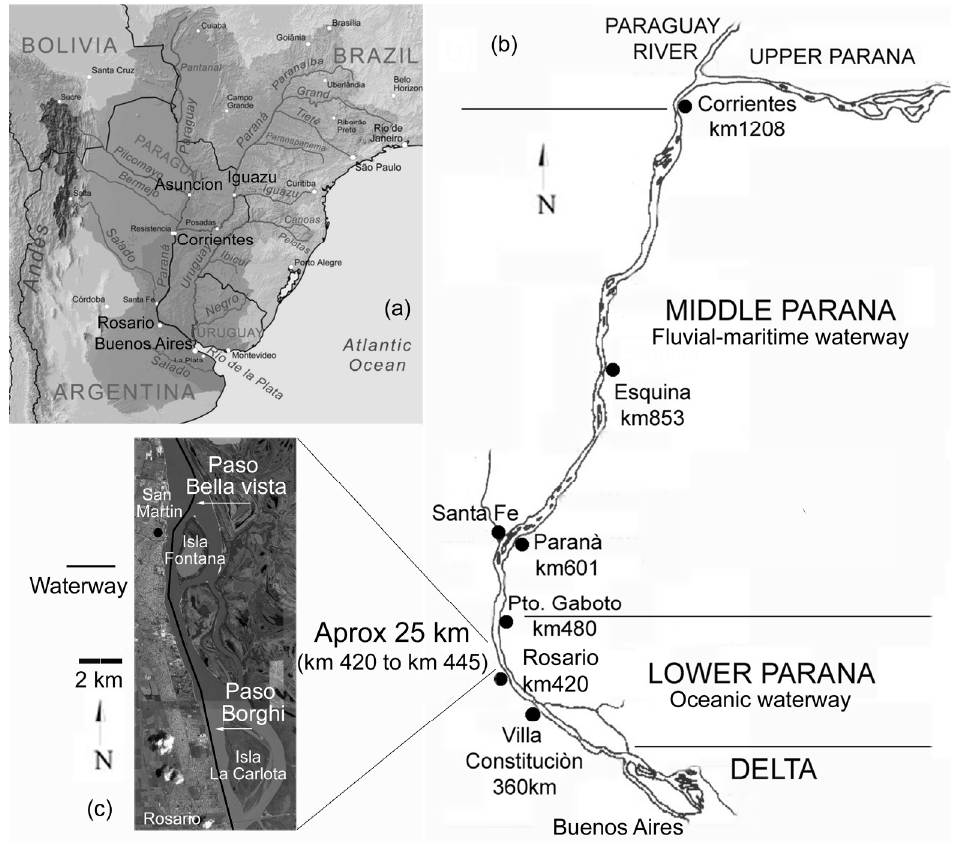
Figure 1. ( a ) The Parana River in the context of “La Plata Basin” watershed; ( b )